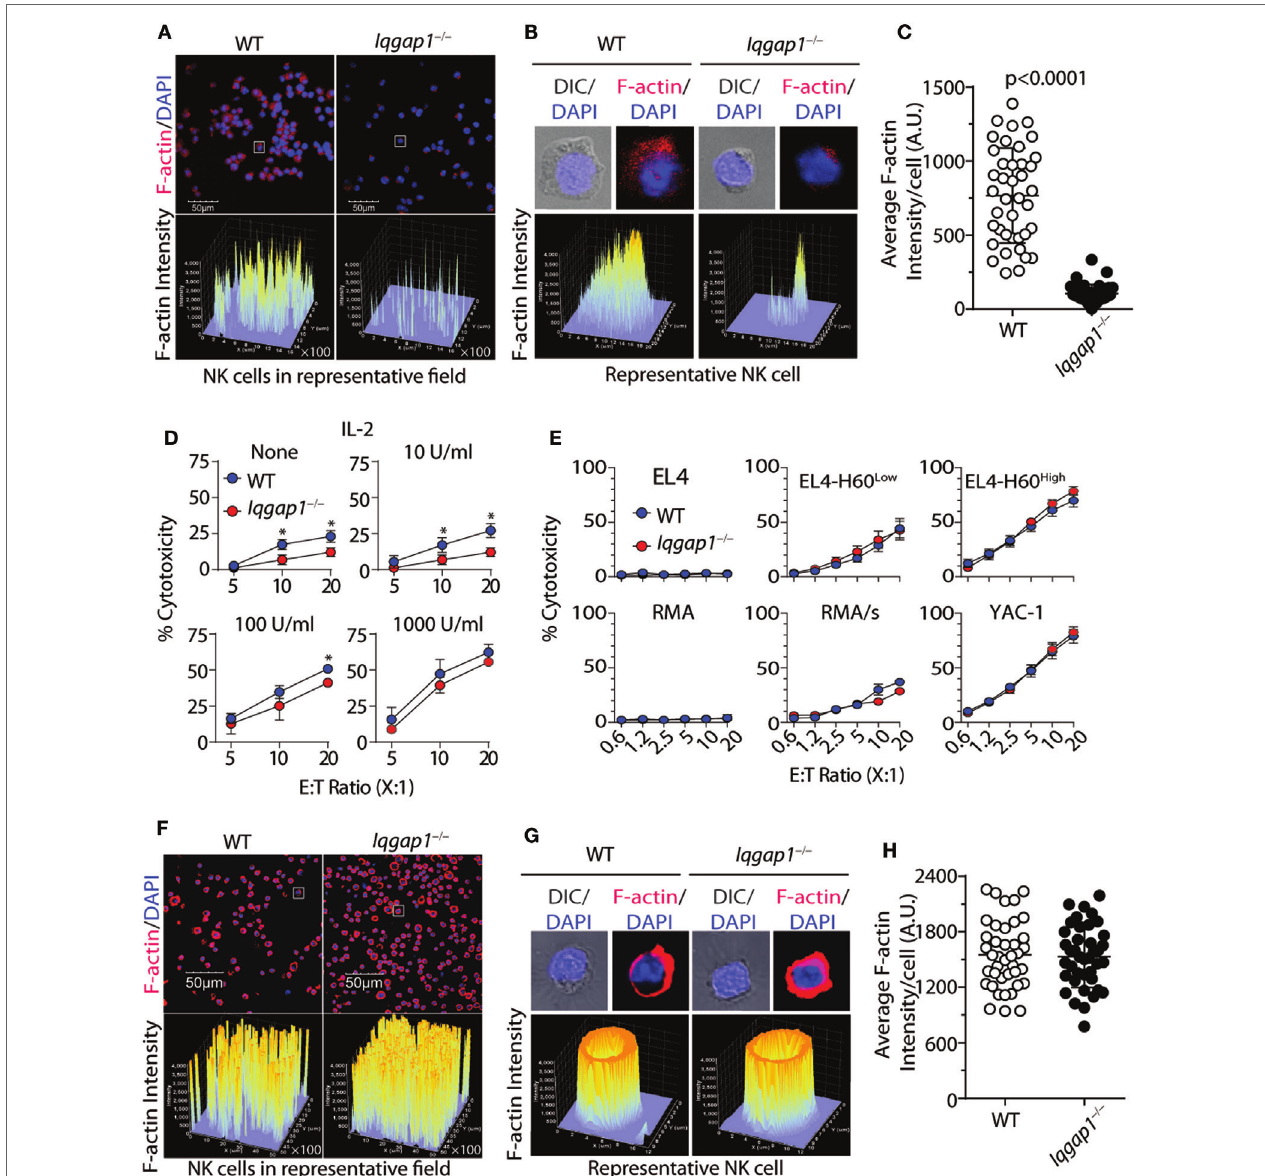
FigUre 4 | IL-2 rescues actin polymerization and cytotoxic potential of Iqgap1 − / − natural killer (NK) cells. (a) Fluorescently labeled phalloidin was used to assess the accumulation of F-actin in splenic NK cells isolated from wild-type (WT) and Iqgap1 − / − mice. These cells were counterstained with DAPI, and fluorescent intensity of phalloidin is shown for cell populations at 40 × magnification. (B) Inset of representative cells isolated from WT and Iqgap1 − / − mice indicated by the white box in panel (a) . (c) Quantified F-actin intensity in arbitrary units (A.U.) is shown for 40 cells selected from the field in panel (a) . (D) Ex vivo cytotoxic potential of WT and Iqgap1 − / − NK cells was assessed by the standard 4-h 51 Cr-release assay against YAC-1 targets at an effector to target ratio of 10:1 with increasing amounts of IL-2 added at the beginning of the assay. (e) Cytotoxicity of IL-2-cultured WT and Iqgap1 − / − NK cells co-cultured with multiple tumor lines at the indicated effector to target ratios. (F) IL-2 cultured WT and Iqgap1 − / − NK cells were treated as in panel (a) , and images were taken at 20 × magnification. White boxes indicate WT and Iqgap1 − / − NK cells used for single-cell inset in panel (g) where the fluorescent intensity of phalloidin is shown and (h) F-actin intensity was quantified as in panel (c) . Error bars represent SD (c,h) or SEM (D,e) using four to eight mice in at least two independent experiments, * p < 0.05 using two-tailed Student’s t